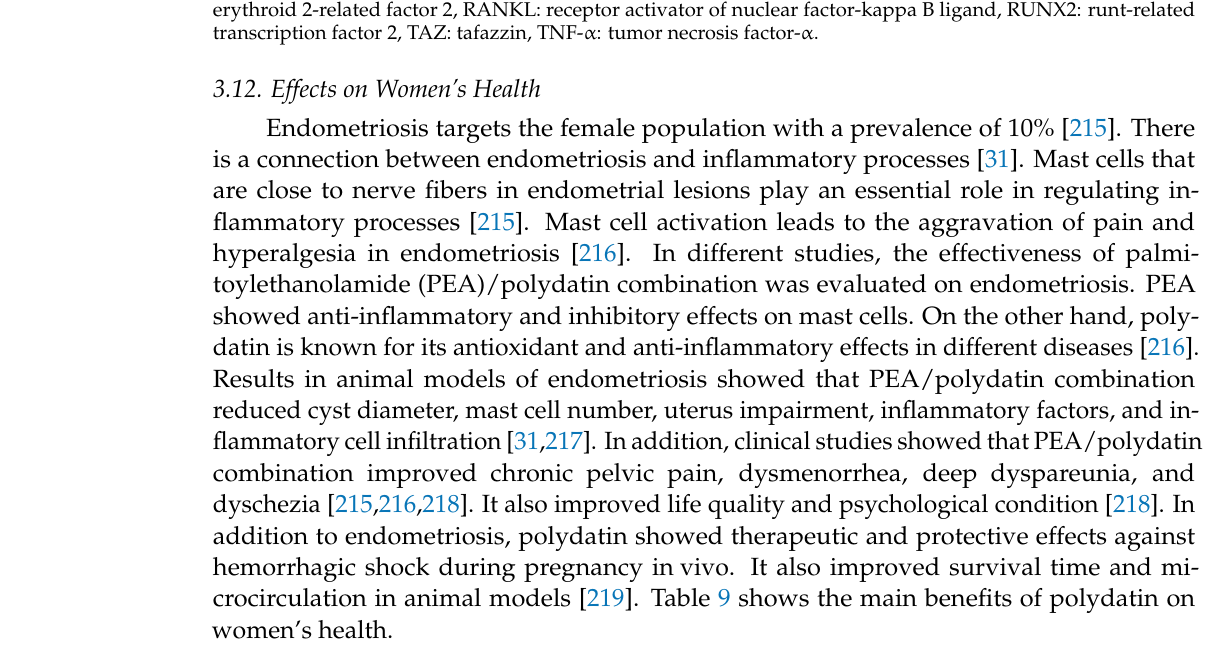
Table 9. Effects of polydatin on women’s